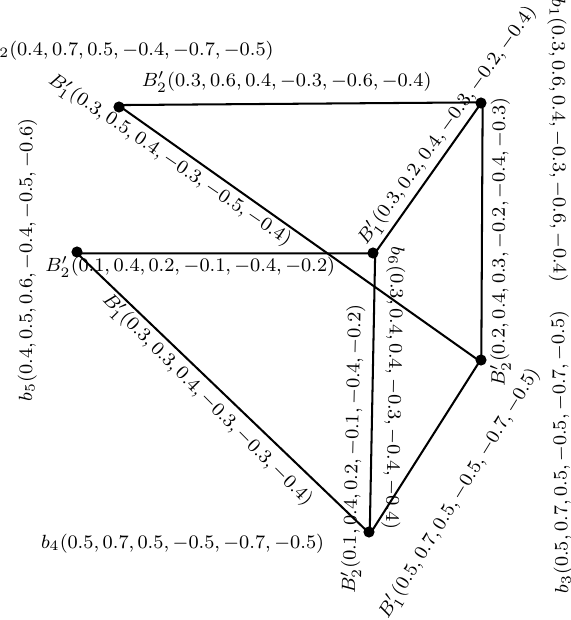
) . , B (cid:48) 2 1 , B ′ = ( B ′ , B ′ ) bs 1 2